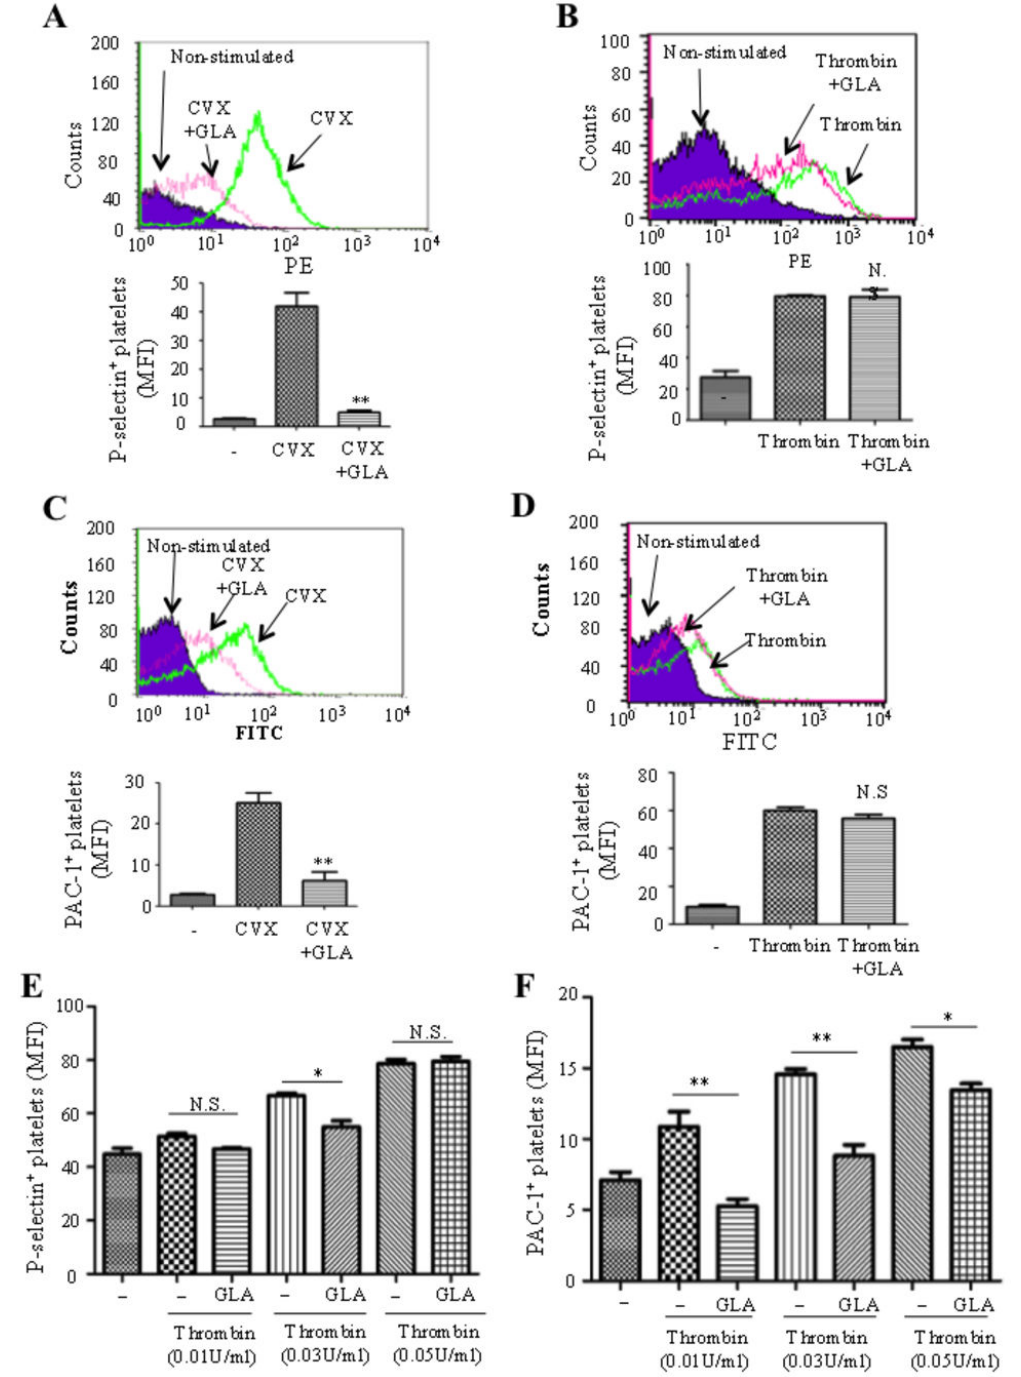
Figure 6. Effects of GLA on single-platelet activation. Gel-filtered platelets (2.5×10 8 /ml) were pre-incubated with vehicle (DMSO) or GLA (0.5 μg/ml) for 10 min in the presence of PE-conjugated P-selectin antibody or FITC-conjugated PAC-1. Samples were then challenged with CVX (0.2nM) (A, C) or thrombin (0.1U/ml) (B, D) and incubated for 10 min. P-selectin expression (A, B) and PAC-1 binding (C, D) were monitored by flow cytometry. Similarly, using the effective inhibitory dose of GLA (0.01μg/ml), P- selectin secretion (E) and integrin activation (F) induced by lower doses of thrombin were tested. Data plotted are means ± standard errors of three individual experiments. *P < 0.05. **P < 0.01. N.S., not significant compared to vehicle control.. The statistical significance was determined by one-way ANOVA analysis of variance with the Bonferroni post test. doi: 10.1371/journal.pone.0085120.g006 PLOS ONE |